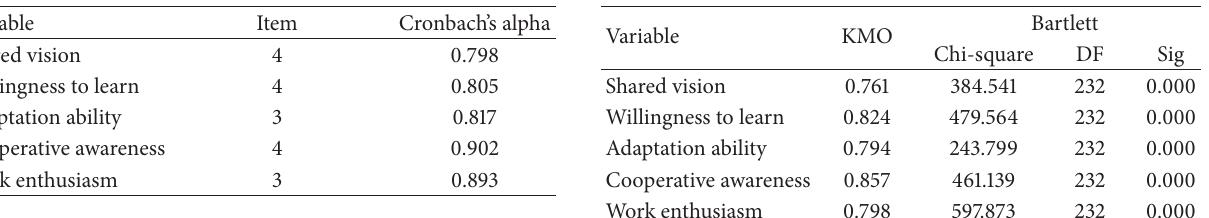
Table 3: Reliability analysis of measurement variables. Table 4: Validity analysis of measurement